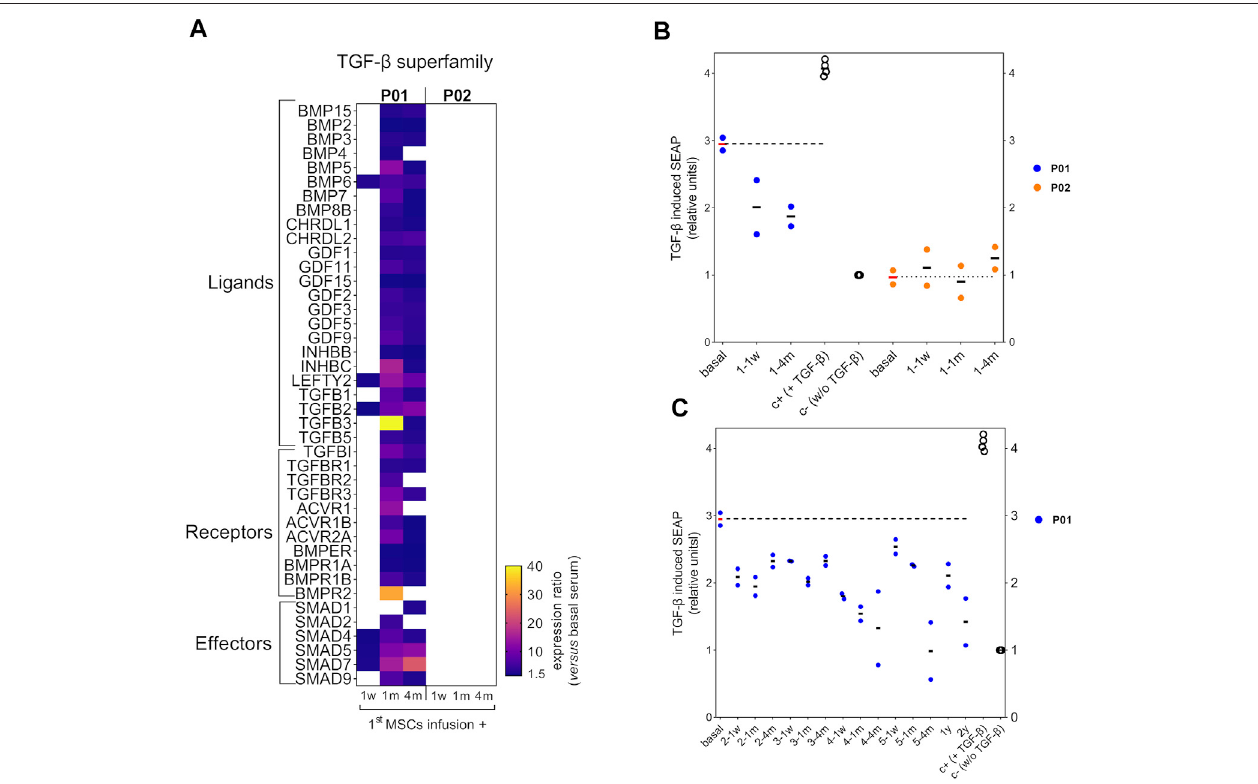
FIGURE 3 | Circulating TGF- β superfamily members expression and bioactivity after MSCs therapy in OI patients. (A) Heatmap showing the expression ratio of TGF- β superfamily members after the 1st MSCs infusion in P01 and P02, calculated as the fl uorescent signal intensity of target proteins after the MSCs therapy, 1 week (1w), 1 month (1 m) or 4 months (4 m) versus the fl uorescent intensity of target proteins from each patient ’ s basal serum. To be considered, a cutoff ratio of ±1.5 was established. (B) Scatter plot showing TGF- β induced SEAP of HEK-Blue-TGF- β TM cells exposed to P01 and P02 sera collected after the fi rst MSCs infusion and comparedtotheresultsobtainedwithbasalserumforeachpatient.TheTGF- β inducedSEAPisshownnormalized versus thenegativecontrol. (C) Scatterplotshowing TGF- β inducedSEAPofHEK-Blue-TGF- β TM cellsexposedtotheserafromP01obtainedduringthe2nd,3rd,4th,5thinfusionsandfollow-upvisits,andcomparedtothe results obtained with basal serum. Two independent experiments were performed with P01 and P02 sera, each of one with their respective positive (c+) and negative controls (c-). Within each independent experiment, each condition was performed in octuplicates. Data are mean ± standard deviation obtained from the two independent experiments. Each dot represents an independent experiment.Dashed horizontal lines illustrate the TGF- β bioactivity level of basal P01 and P02 sera.